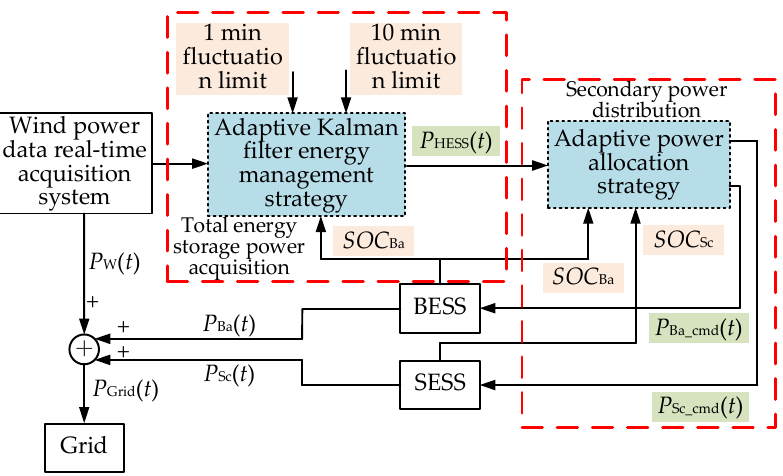
Figure 2. Adaptive energy management strategy for HESS.